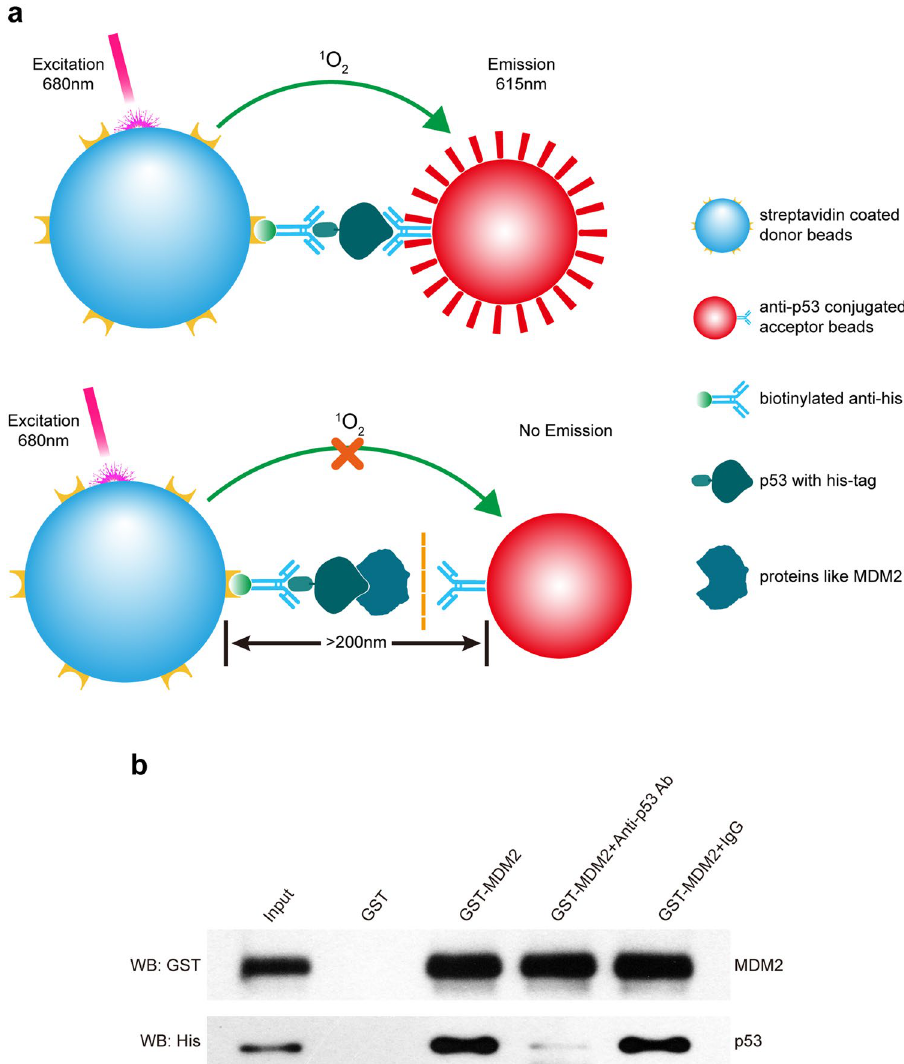
Figure 1. Analysis of the interaction between p53-His and MDM2-GST in cellular extracts. ( a ) A schematic diagram for detection of recombinant protein p53-His in cells using AlphaLISA. Acceptor beads that are directly conjugated to anti-p53 antibodies capture the TAD of p53. Streptavidin coated donor beads capture the immune complex between the biotinylated anti-His antibodies and His tag, bringing donor beads into close proximity to the acceptor beads. After excitation at 680 nm, acceptor beads receive singlet oxygen from donor beads and produce fluorescent emission at 615 nm. As shown in the lower image, if ligands like MDM2, which can block the TAD domain of p53, exist, acceptor beads are not able to capture p53, resulting in no emission. ( b ) GST pull-down assays were performed with pENTER-p53 transfected HEK293T cell lysates as prey and MDM2-GST as bait. Immunoblotting was performed using anti-His and anti-GST antibodies. p53-His was pulled down by MDM2-GST but not by GST. When anti-p53 antibodies were added to the cell lysates, p53-His pulled down by MDM2-GST was remarkably reduced. However, isotype IgG had no